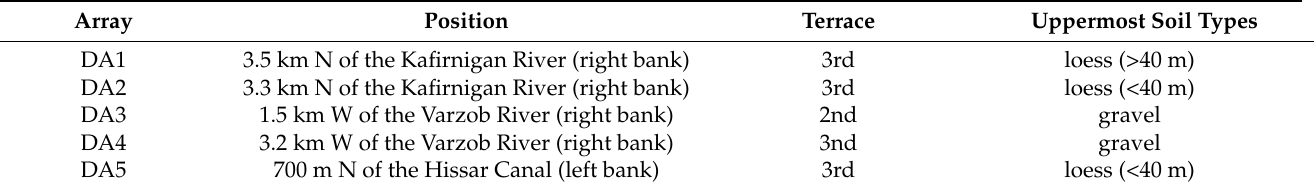
Table 3. Microtremor array measurements (MAM) with details on location, position relative to the three terraces, and prevalent soil types visible from the surface.